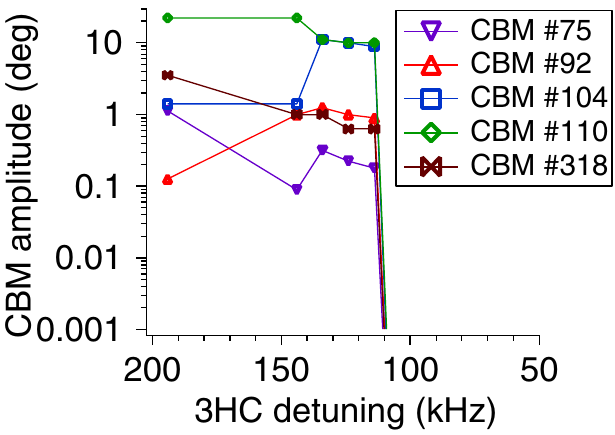
FIG. 1. (Color) CBMs amplitude versus 3HC tuning for a 70% (cid:1) 315 mA , E (cid:1) 2 : 0 GeV . filling of the ring; I beam